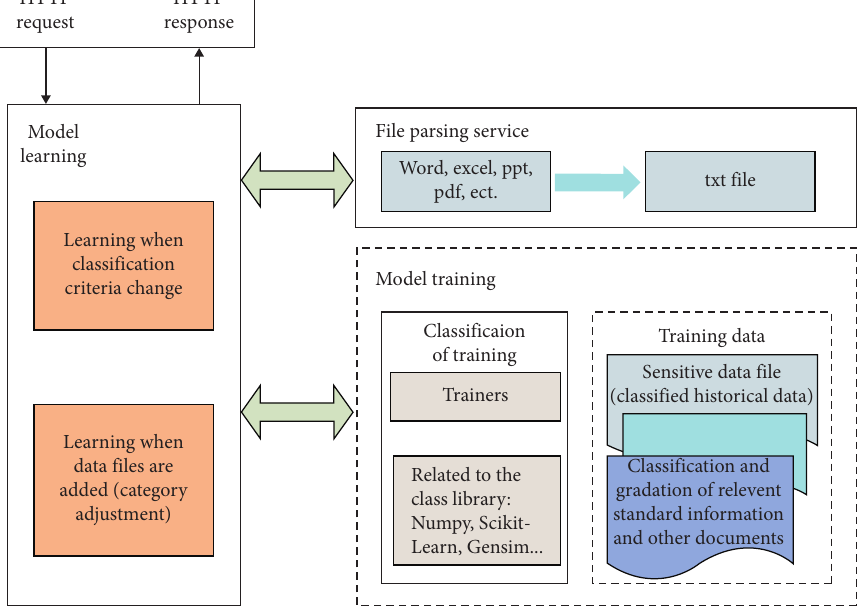
Figure 6: AI intelligence classification model learning frame